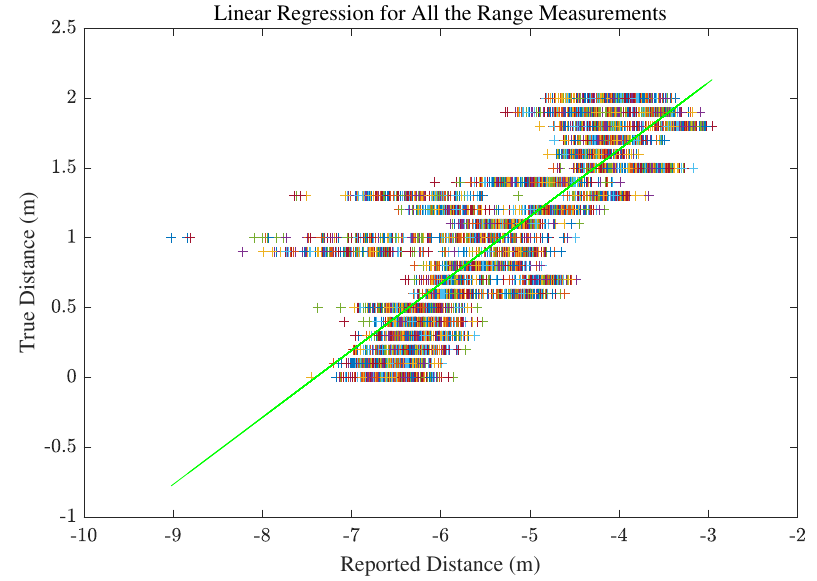
Figure 5. Linear regression applied to all the range